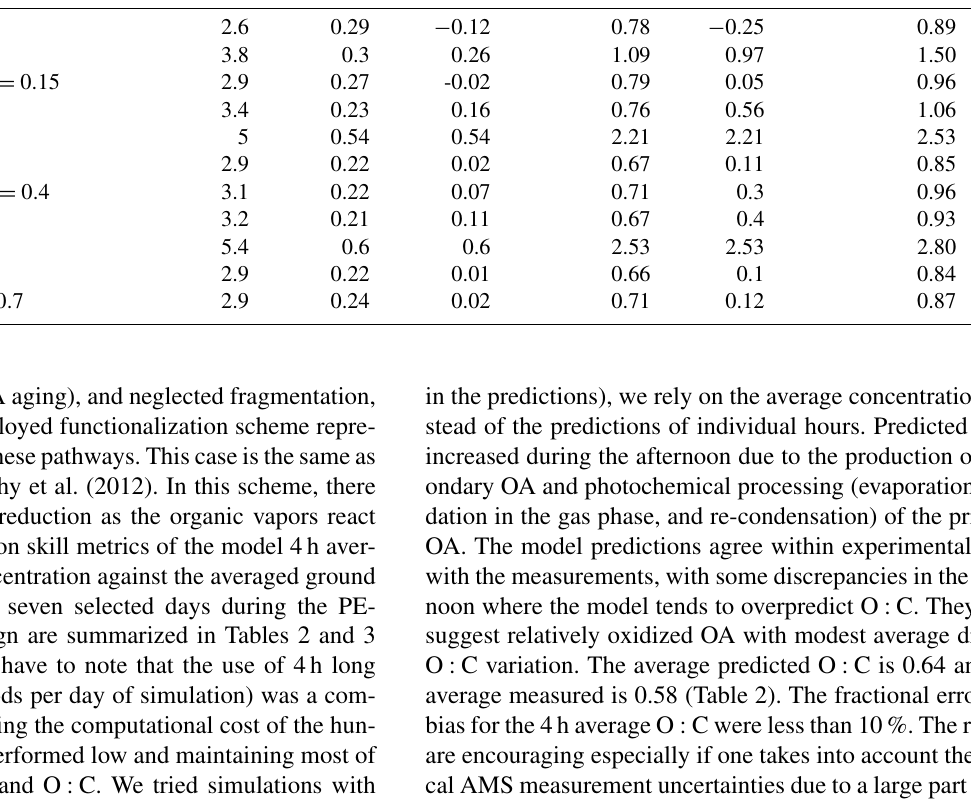
one-bin/bSOA/ b = 0 . 15